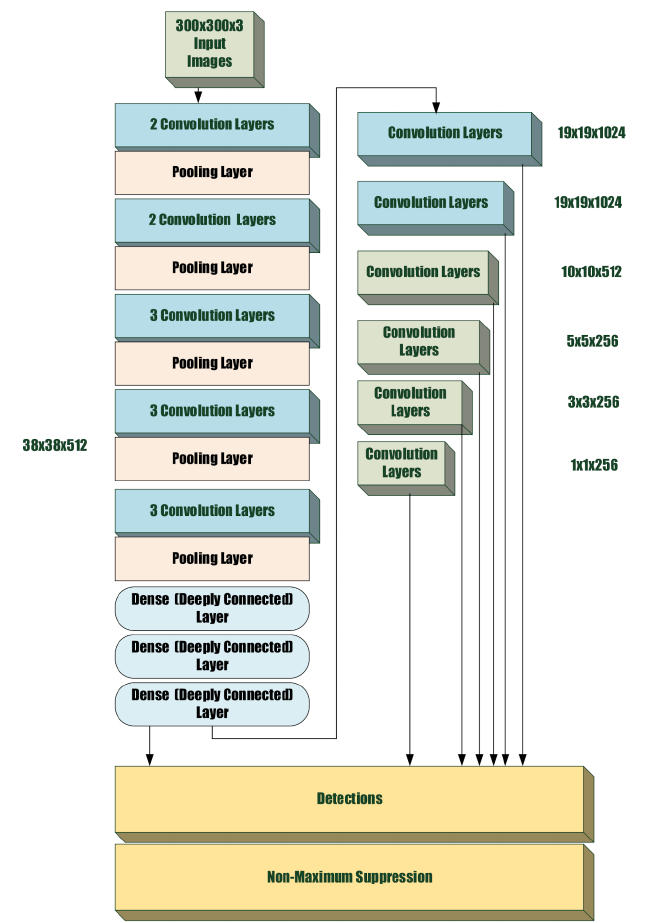
Figure 5. The structure of the SSD